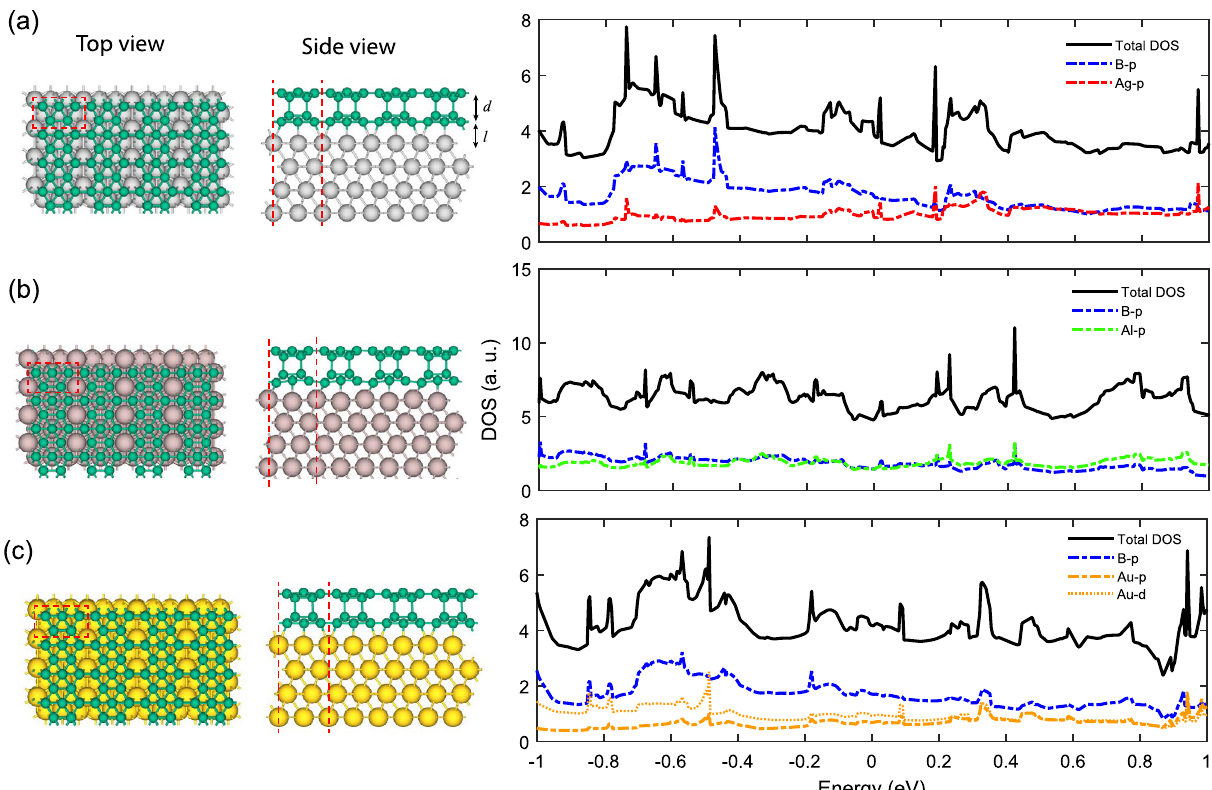
Figure 3. Structural configuration of ( a ) Ag-, ( b ) Al-, and ( c ) Au-supported bilayer borophenes with their partial density of states (PDOS) projected on different atomic